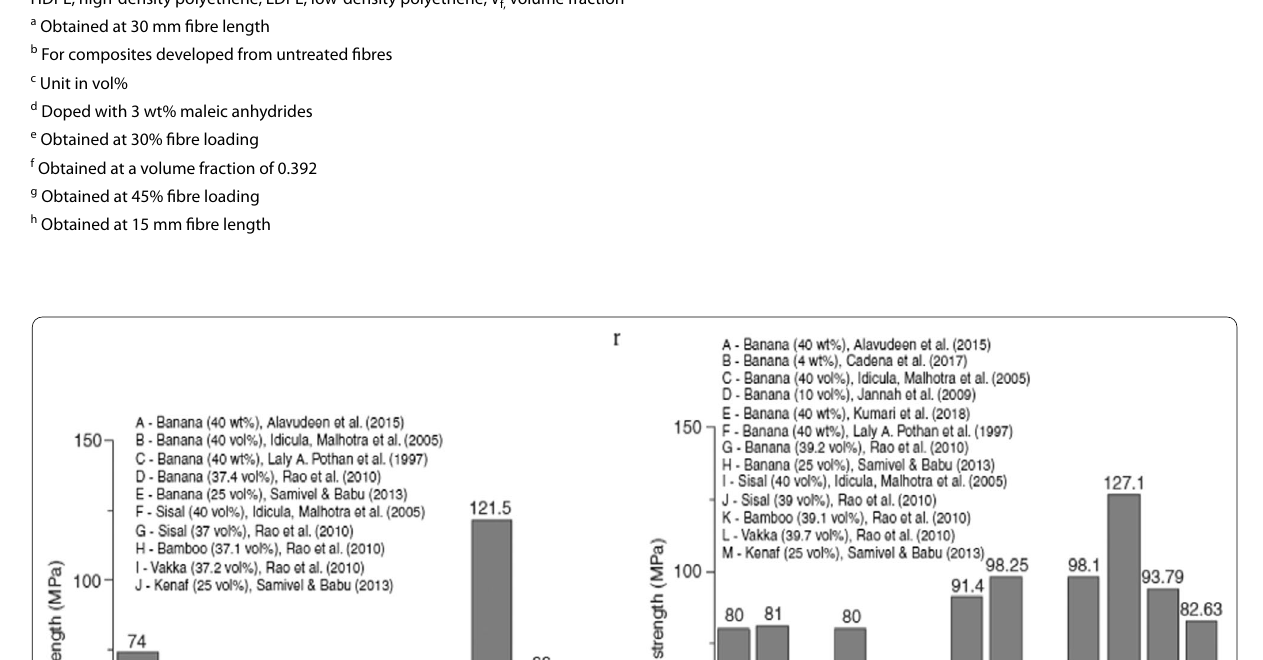
HDPE, high-density polyethene; LDPE, low-density polyethene; V f, volume fraction a Obtained at 30 mm fibre length b For composites developed from untreated fibres c Unit in vol% d Doped with 3 wt% maleic anhydrides e Obtained at 30% fibre loading f Obtained at a volume fraction of 0.392 g